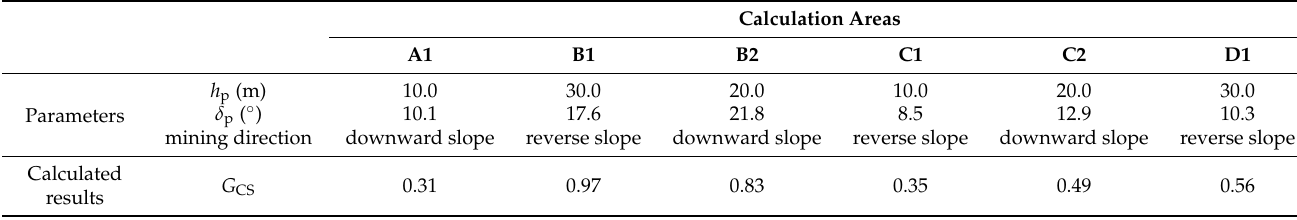
Table 8. Slope instability coefficient of slope